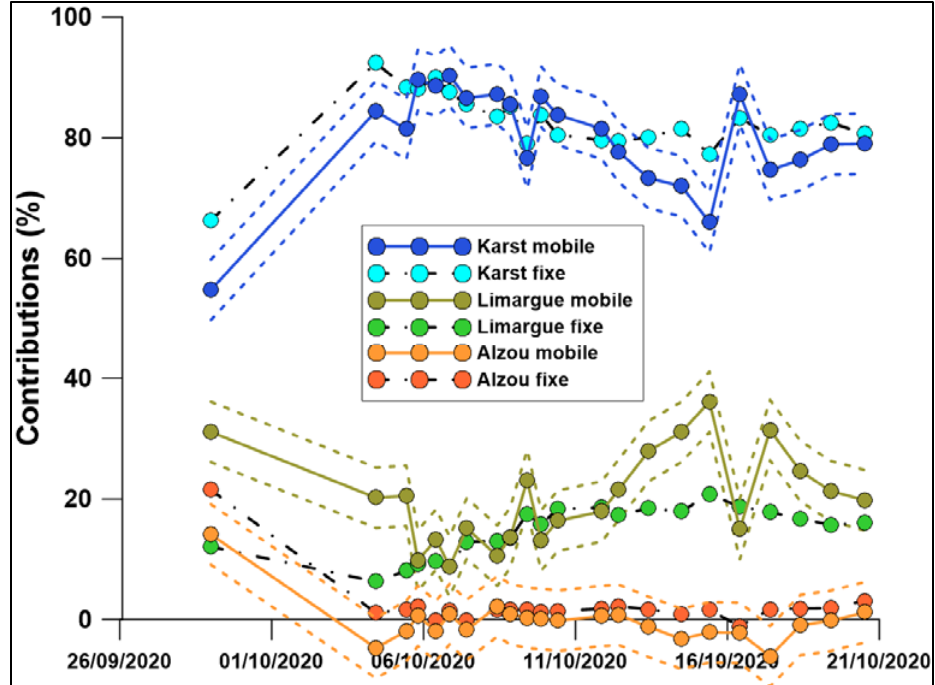
Figure 8. Contributions results of the mobile source mixing model for Saint Sauveur compared with fixed source model.